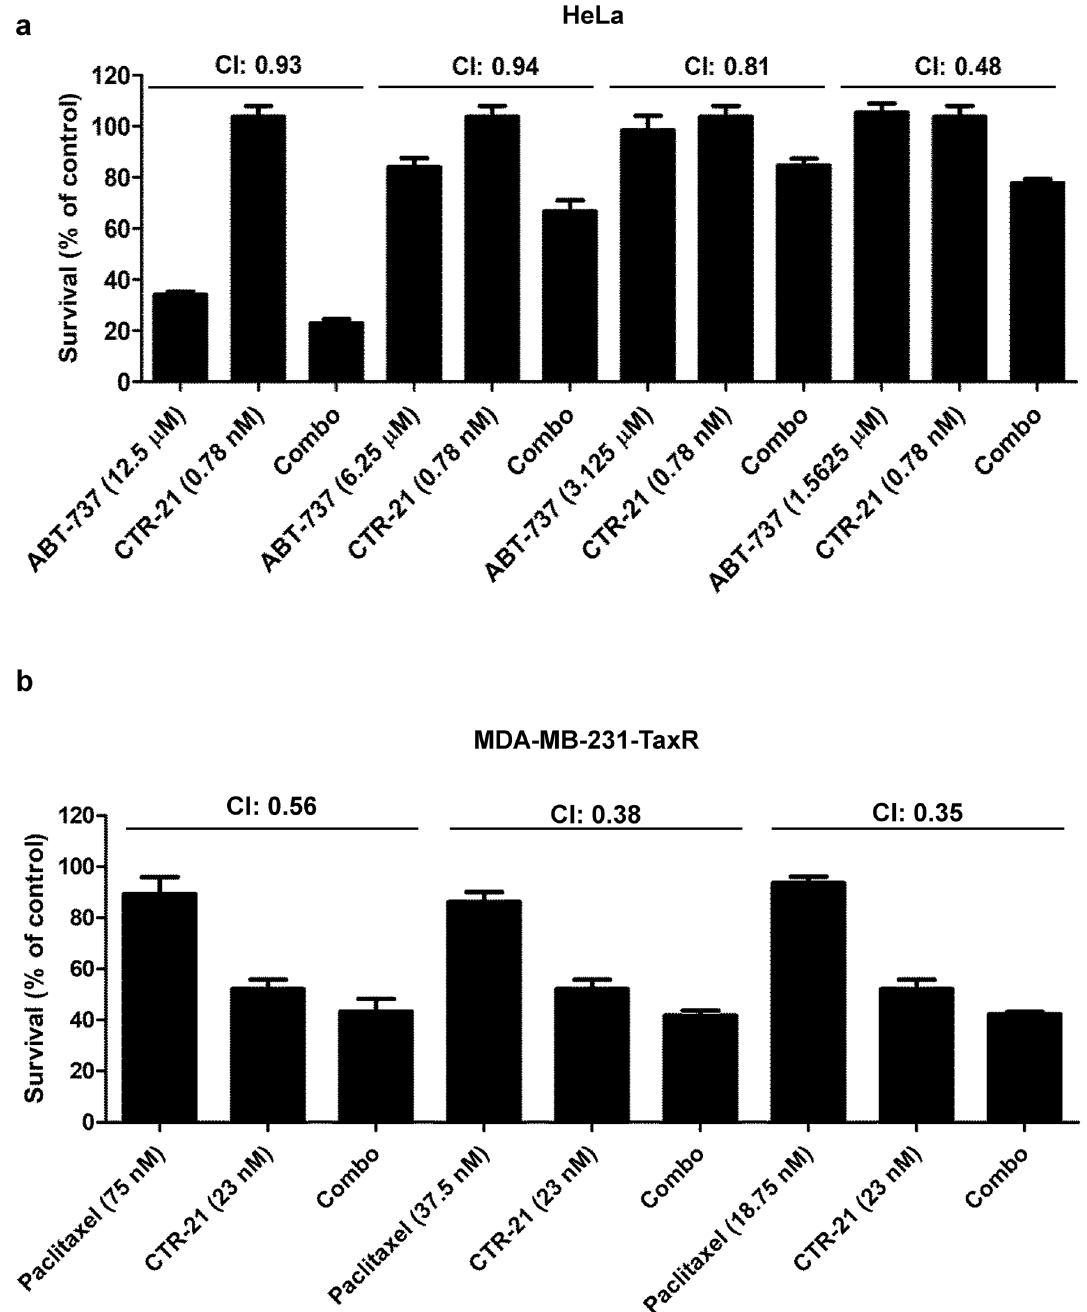
Figure 6. CTR-21 shows strong synergistic effects when combined with ABT-737 (Bcl-XL inhibitor) or paclitaxel. ( a ) CTR-21 kills HeLa in a synergistic manner with ABT-737. Cells were treated with 0.78 nM CTR-21 and indicated concentrations of ABT-737. CI denotes combinatorial index, calculated according to described previously 19 . ( b ) CTR-21 effectively kills paclitaxel-resistant cells when combined with paclitaxel. The paclitaxel-resistant MDA-MB-231TaxR cells were treated with 23 nM of CTR-21 and indicated concentrations of